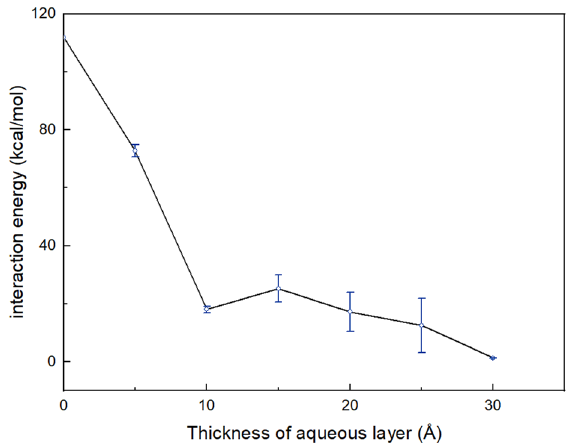
Figure 8. The interaction energy between naphthalene and kaolinite (alumina octahedral surface) under the different thicknesses of an aqueous layer.